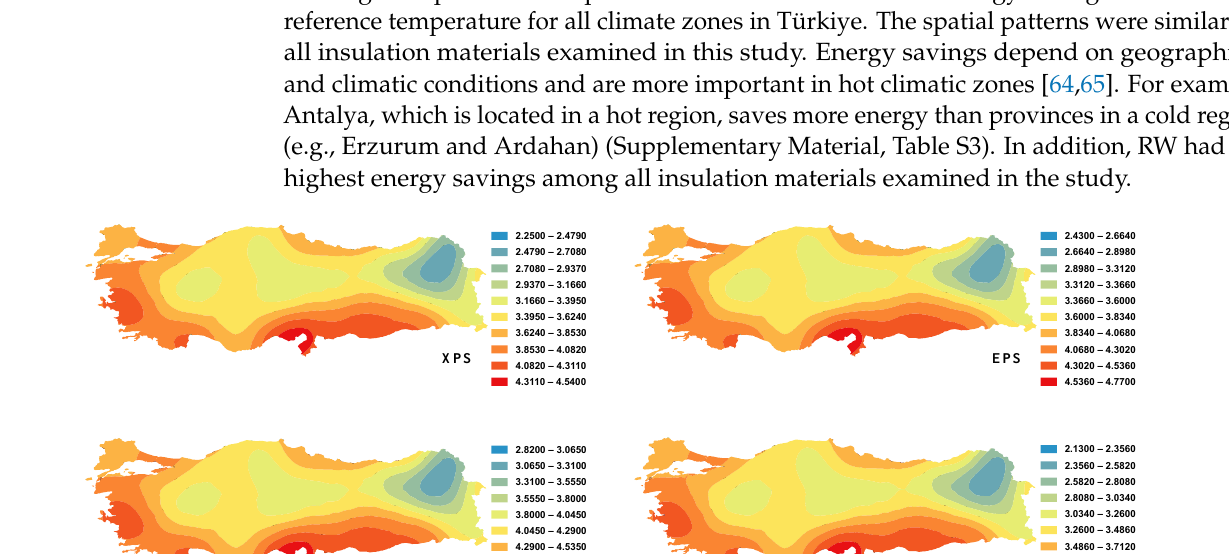
Table 6. Payback periods (year) considering different reference temperatures and four insulation materials in selected cities.